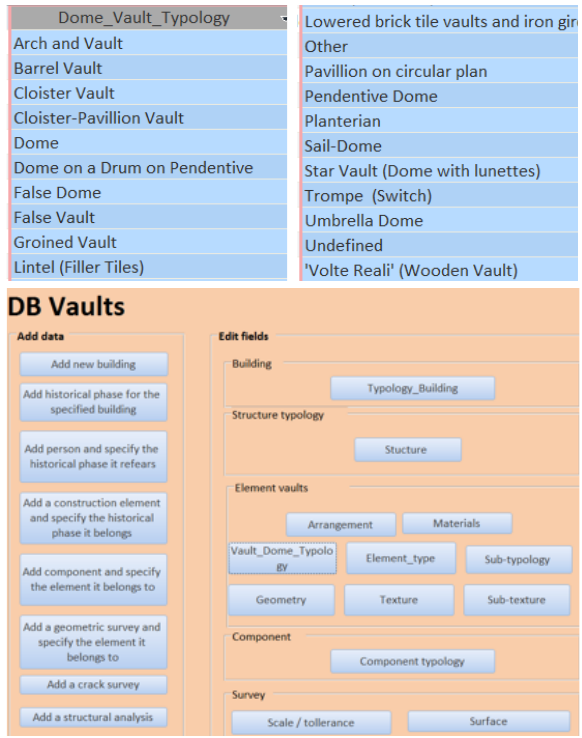
Figure 9. The semantic-based query of the Geo Database allows to cross relate different properties of each vaulted element across time and